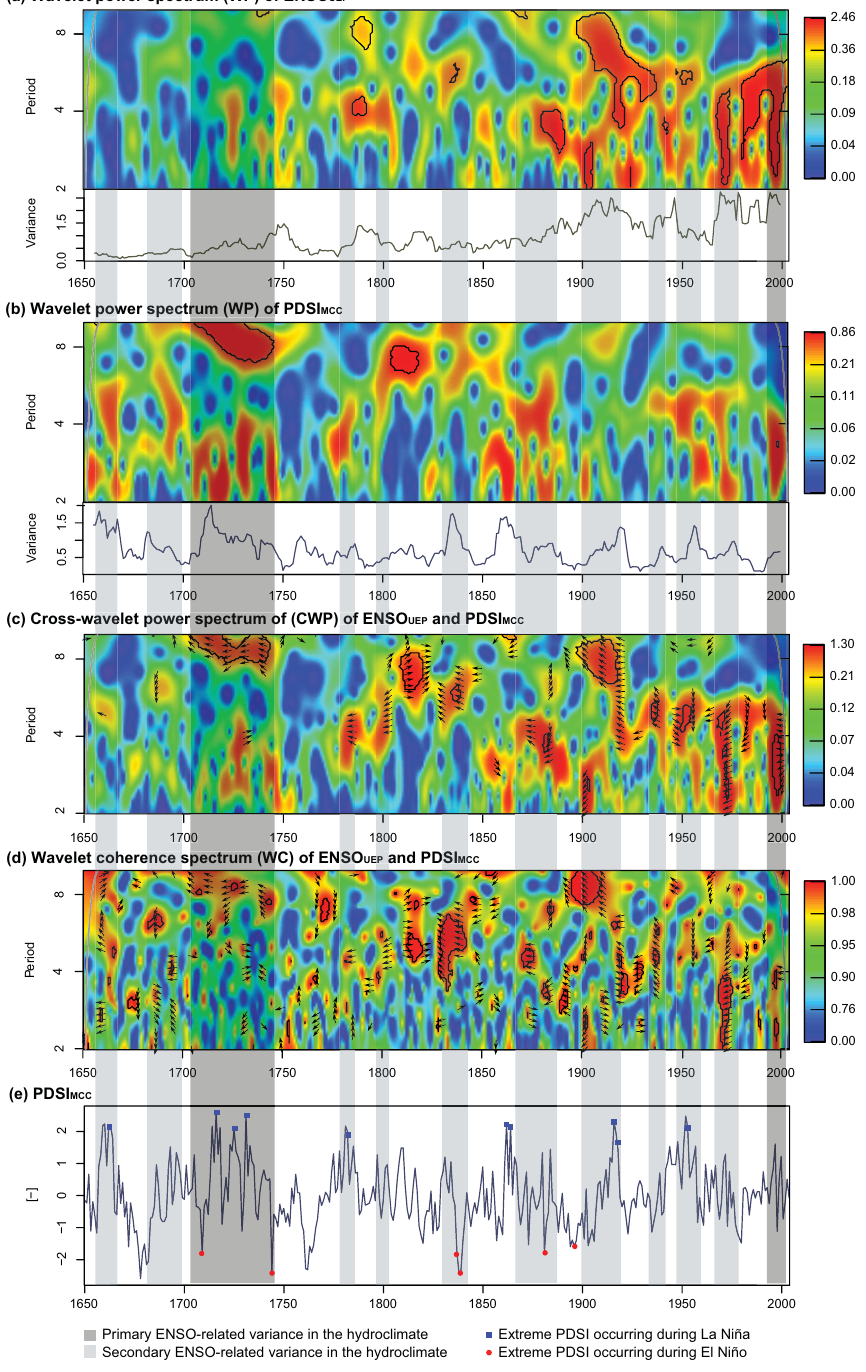
Figure 6. Wavelet analysis of ENSO and PDSI MCC over the period 1650–2004. Wavelet power spectrum of (a) ENSO UEP and (b) PDSI MCC , (c) cross-wavelet power spectrum and (d) wavelet coherence spectrum of ENSO UEP and PDSI MCC , and (e) time series of PDSI MCC . Tiles (a) and (b) also shows total variances of time series calculated with moving window of 21 years. The dark grey columns indicate periods with primary ENSO-related variance, and the light grey columns indicate periods with secondary ENSO-related variance in PDSI MCC (see definitions in Table 2). Tile (e) also shows extreme PDSI values that occurred during ENSO events. Extreme values were defined from PDSI data as 5th and 95th percentiles. PDSI data describe the hydroclimate of the March–May